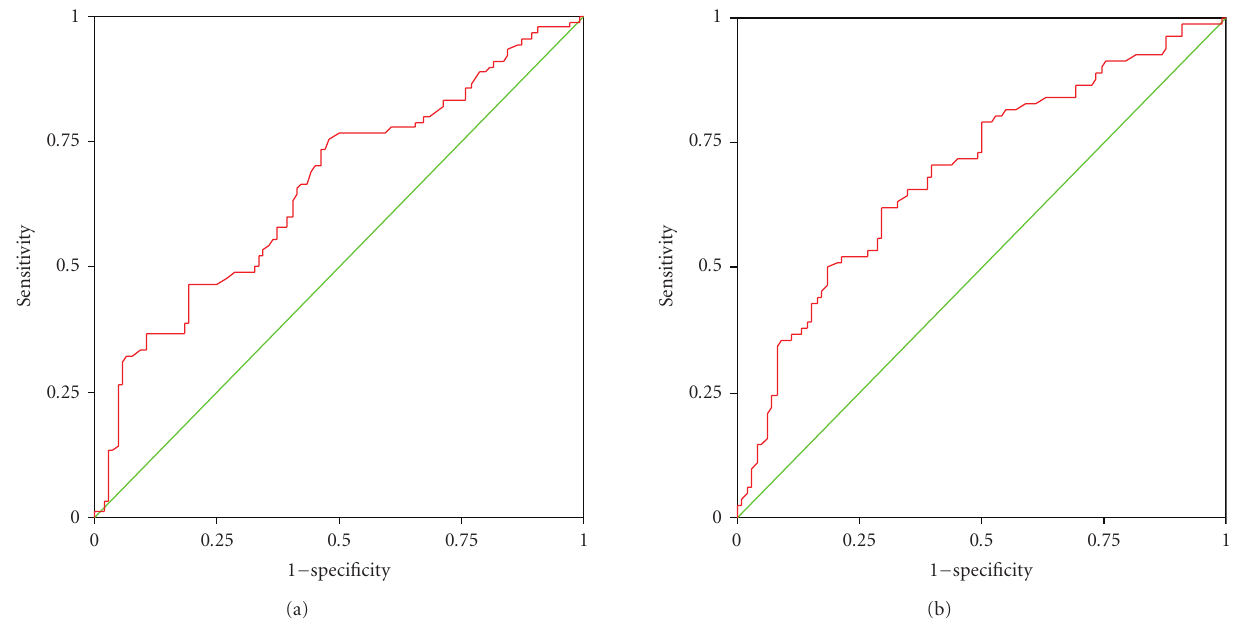
Figure 2: (a) Receiver Operator Characteristic curve between WAZ score and CD4 percentage, and (b) HAZ score and CD4 percentage.